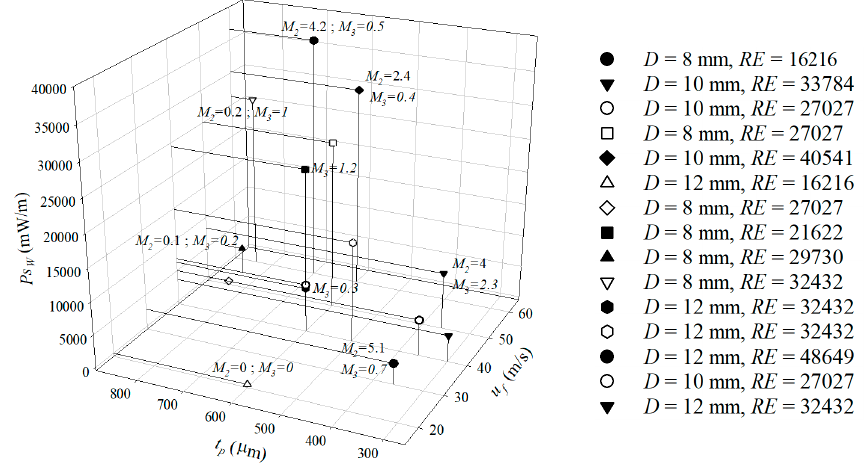
Figure 18. Bending power P sW evolution with thickness and incoming velocity for L = 100